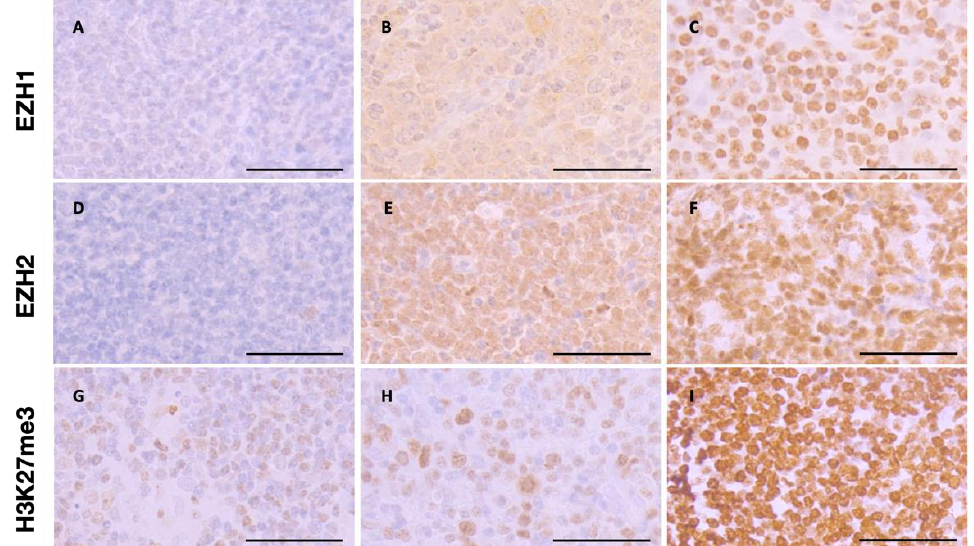
Figure 3. Representative immunohistochemical features of EZH1, EZH2, and H3K27me3. ( A – C ) Immunohistochemical staining showing low ( A ), middle ( B ), and high ( C ) levels of nuclear EZH1 expression. ( D – F ) Immunohistochemical staining showing low ( D ), middle ( E ), and high ( F ) levels of nuclear EZH2 expression. ( G – H ) Immunohistochemical staining showing low ( G ), middle ( H ), and high ( I ) levels of nuclear H3K27me3 expression. Original magnification ×400, the scale bars are 50 μm.